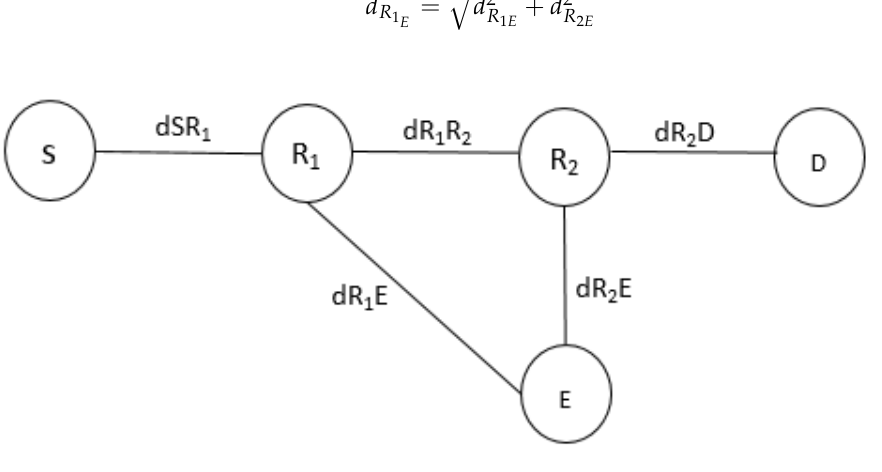
Figure 7. Secrecy Rate vs d R 2 D for the EH System.